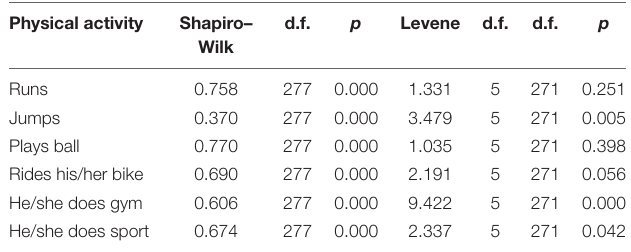
TABLE 7 | Shapiro–Wilk normality test and Levene